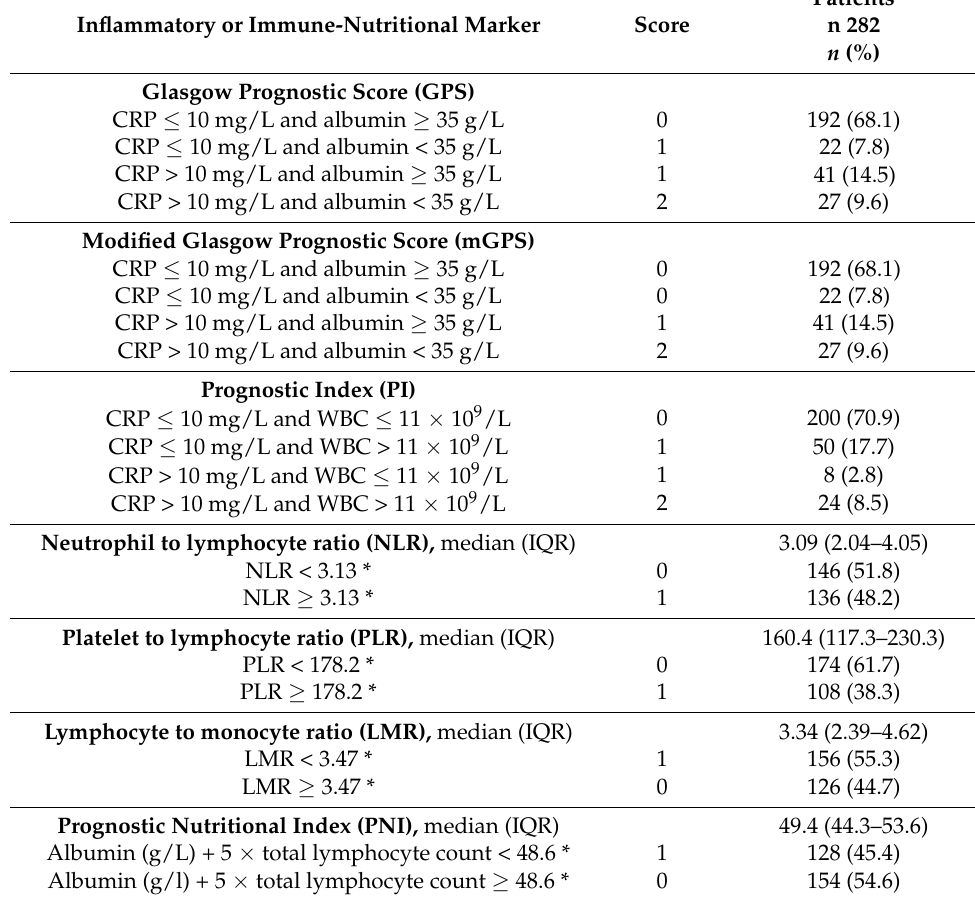
Inflammatory or Immune-Nutritional